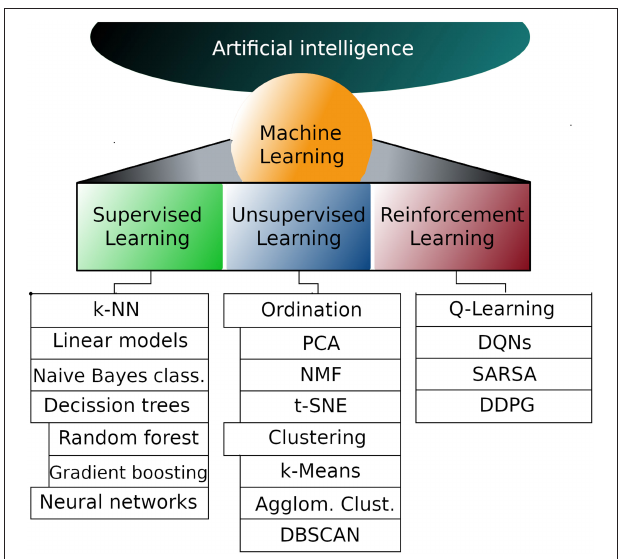
FIGURE 1 | Representative machine learning algorithms. Machine learning is a subfield of artificial intelligence and can be divided into supervised, unsupervised and reinforcement learning. The list of algorithms in each subfield is not exhaustive but instead are the most popular algorithms in each subfield. k-NN, k nearest neighbors; PCA, Principal components analysis; NMF, Non-negative matrix factorization; t-SNE, T-distributed stochastic neighbor embedding; DQNs,Deep Q networks; SARSA, State-action-reward-state-action; DDPG, Deep deterministic policy